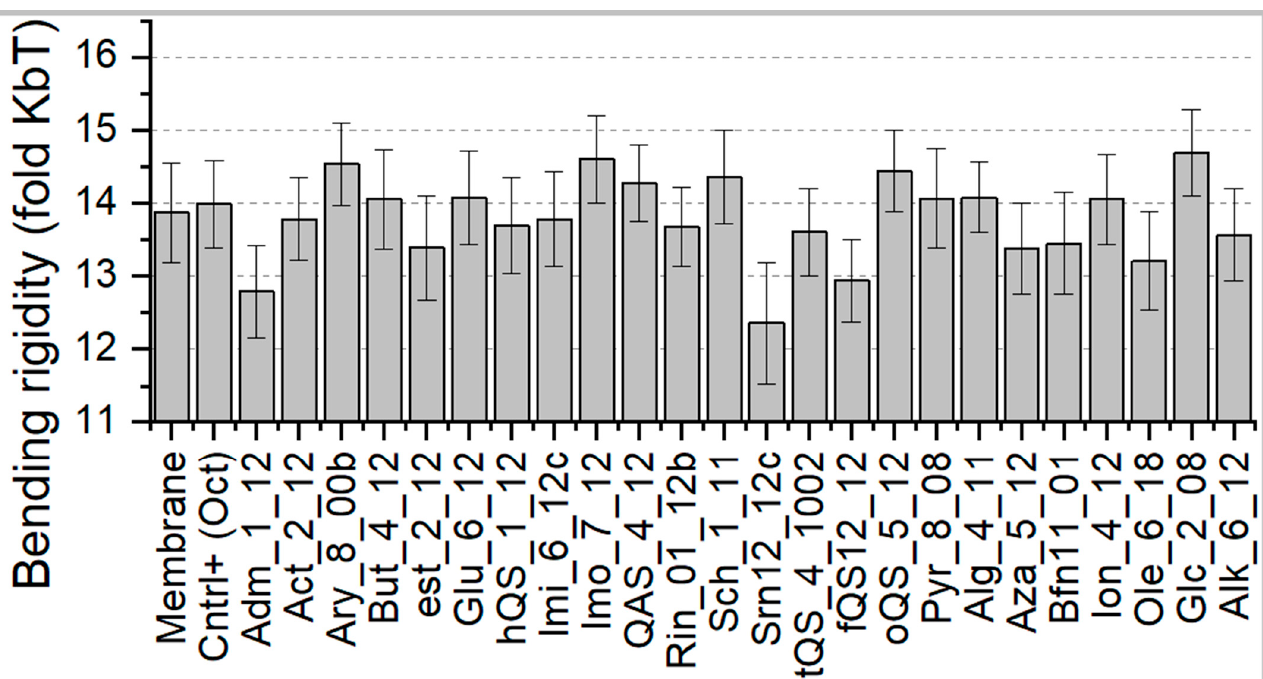
Figure 4. Calculated values of bending rigidity for membrane systems with incorporated Gemini molecules.